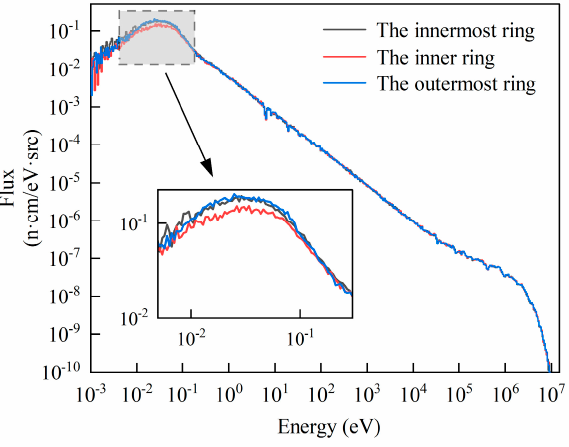
Figure 14. Neutron energy spectra at different locations in fuel assembly.